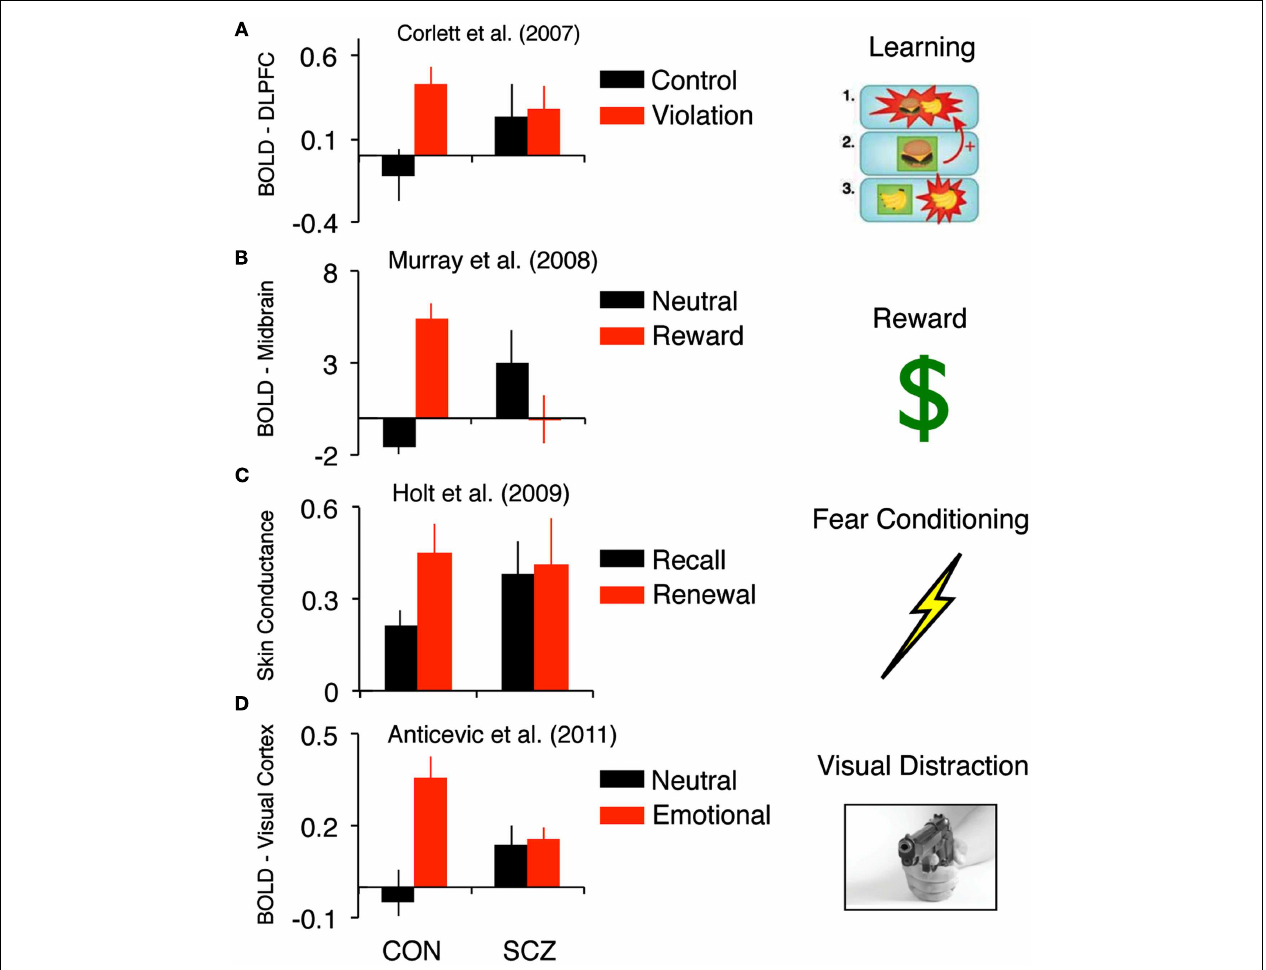
that should be neutral (extinguished), in line with the pattern of responses observed in the brain during causal learning and learning about